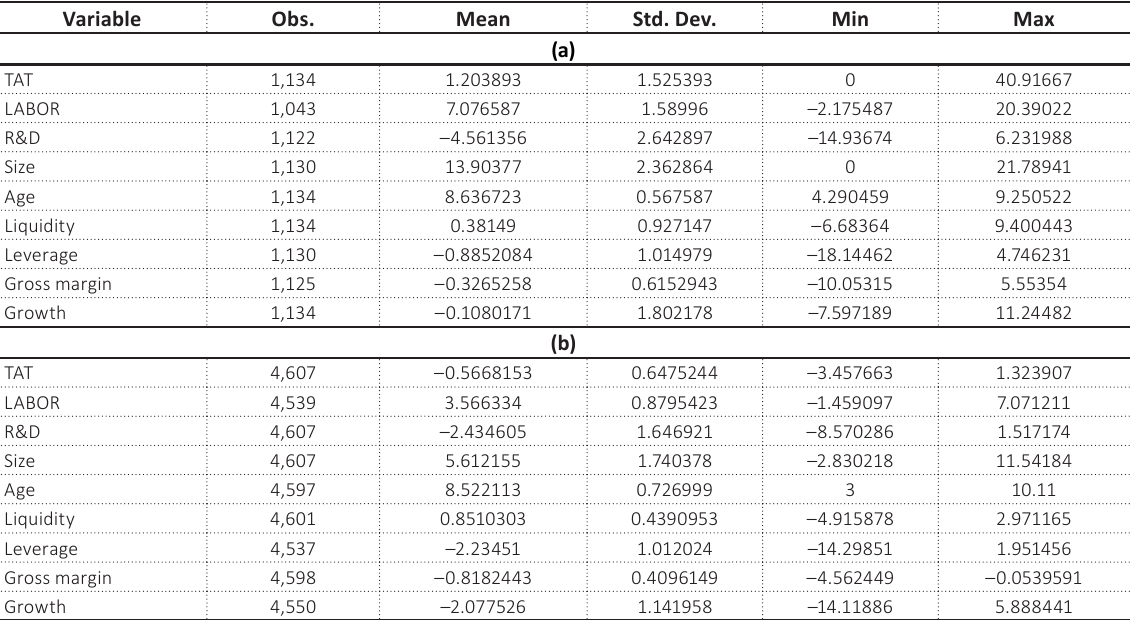
Table 5. Descriptive statistics for the Hungarian data (a) and the US sample (b)